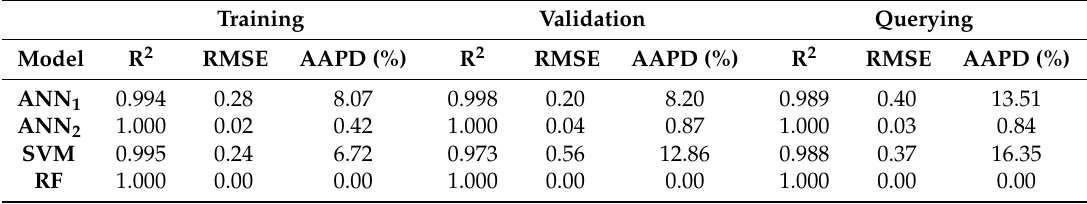
Table 1. Coefficient of determination (R 2 ), root mean squared error (RMSE) and average absolute percentage deviation (AAPD) for training, validation and querying phase, for each model present in this research (artificial neural network with linear function in output neuron (ANN 1 ), artificial neural network with sigmoidal function in output neuron (ANN 2 ), support vector machine (SVM) and random forest